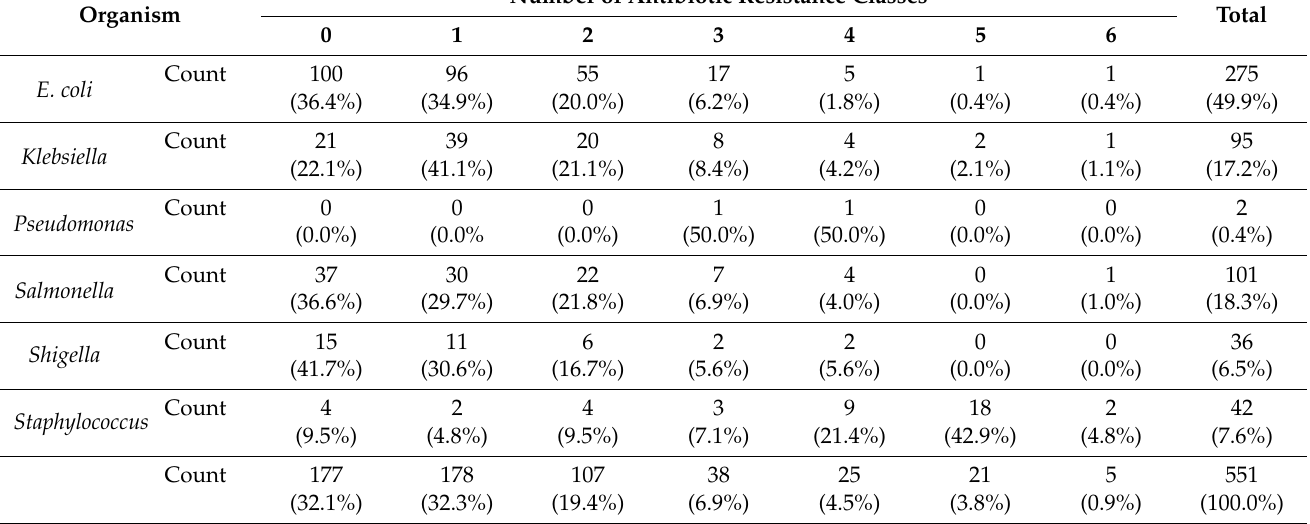
Table 3. Table showing the isolation profiles based on antibiotics resistance class. The 14 antibiotics in this study were categorized into six classes based on CLSI 2021 guidelines. In addition, isolates resistant to three or more classes were considered MDR on the description of an earlier study by Basak et al. (2016)